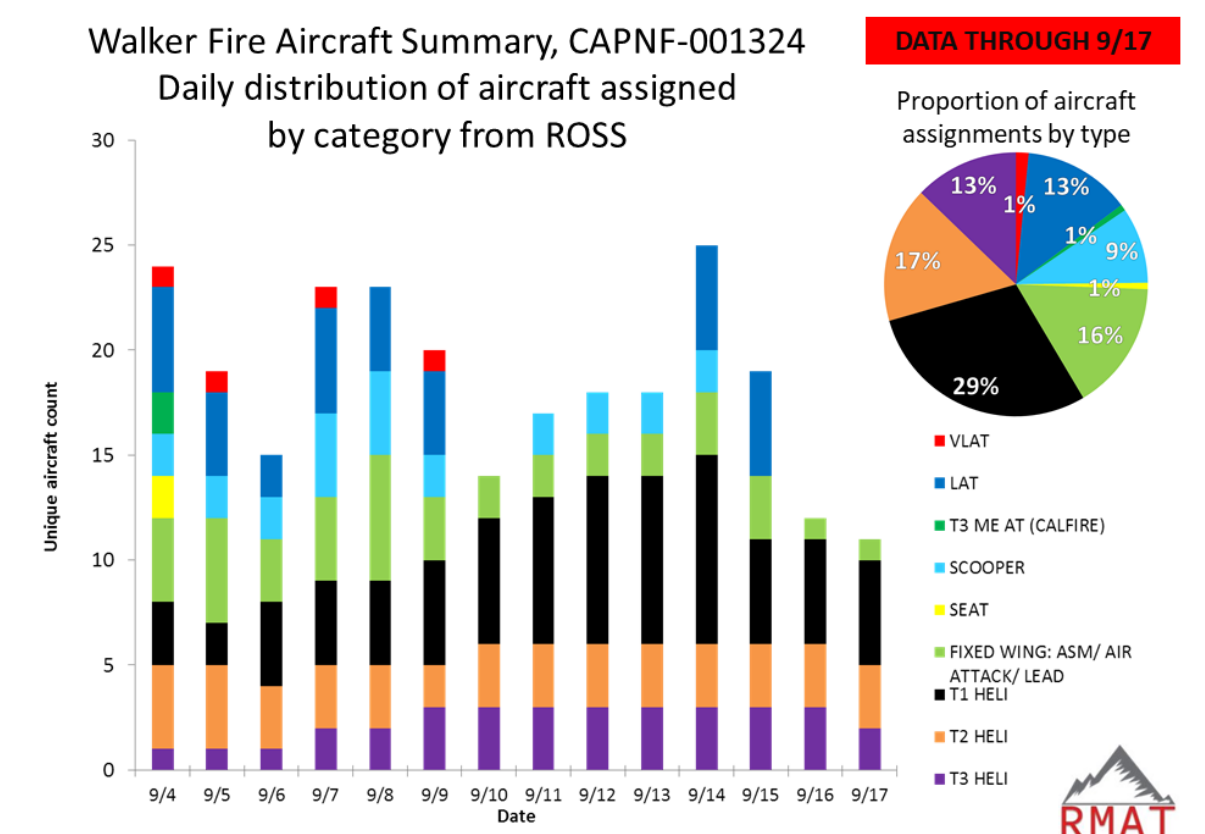
Figure 4. Resource Assignment Timeline from an Aviation Use Summary (AUS) for the Walker Fire from California in 2019. CAPNF—California Plumas National Forest; ROSS—Resource Ordering and Status System; VLAT—very large airtanker; LAT—large airtanker; T3 ME AT—type 3 multi-engine airtanker, CALFIRE—California Department of Forestry and Fire Protection; SEAT—single engine airtanker; ASM—aerial supervision module; LEAD—leadplane; T1 Heli—type 1 helicopter; T2 Heli—type 2 helicopter; T3 Heli—type 3 helicopter.